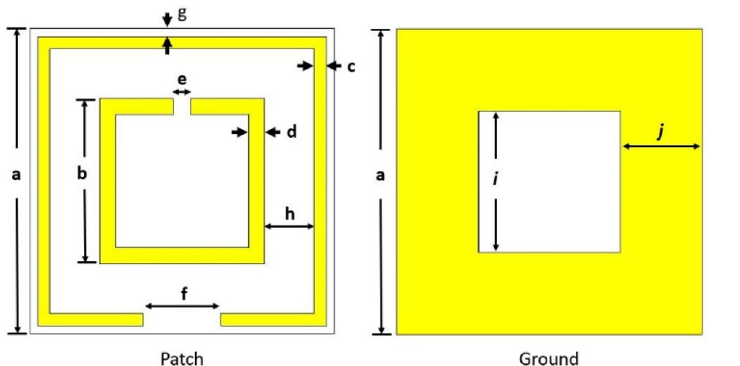
Figure 3. The patch and ground dimensions: a = 9.5 mm, b = 5.14 mm, c = 0.38 mm, d = 0.5 mm, e = 0.53 mm, f = 2.42 mm, g = 0.25 mm, h = 1.55 mm, i = 5.1 mm, j = 2.55